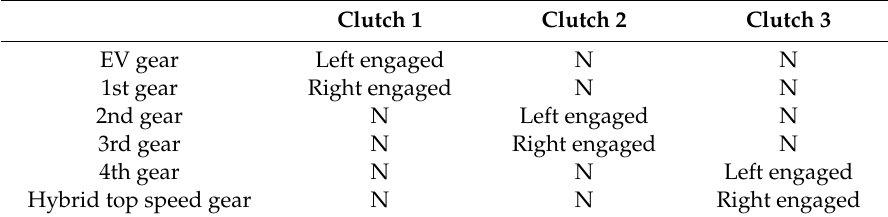
Figure 9. Gearbox system model. Table 4. Clutch schedule.